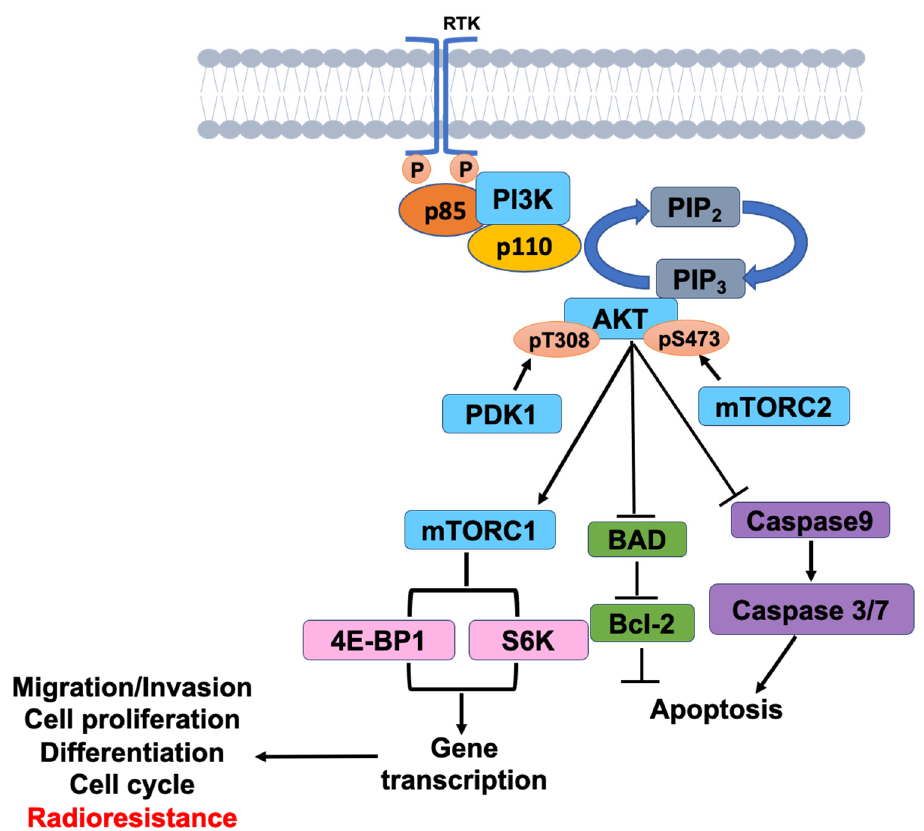
Figure 1. PI3K/AKT/mTOR signaling in HNSCC.